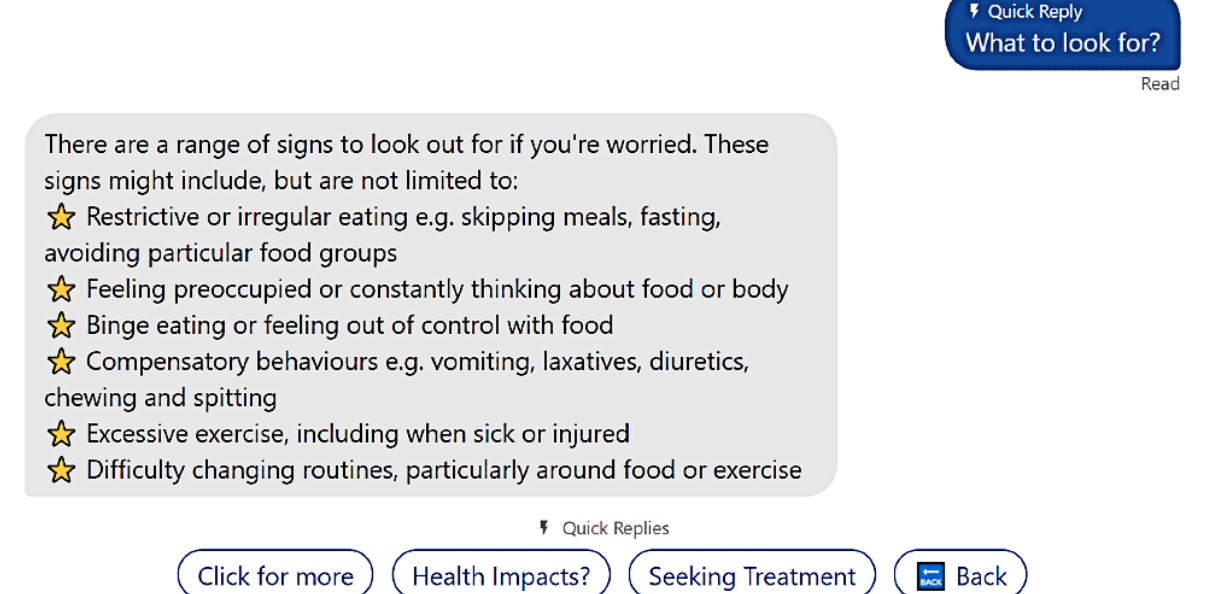
Figure 3. An example of one of KIT’s psychoeducation conversations in the “help for another” pathway where the user has asked “What to look out for?” as in eating disorder warning signs. The “Click for more” option provides further warning